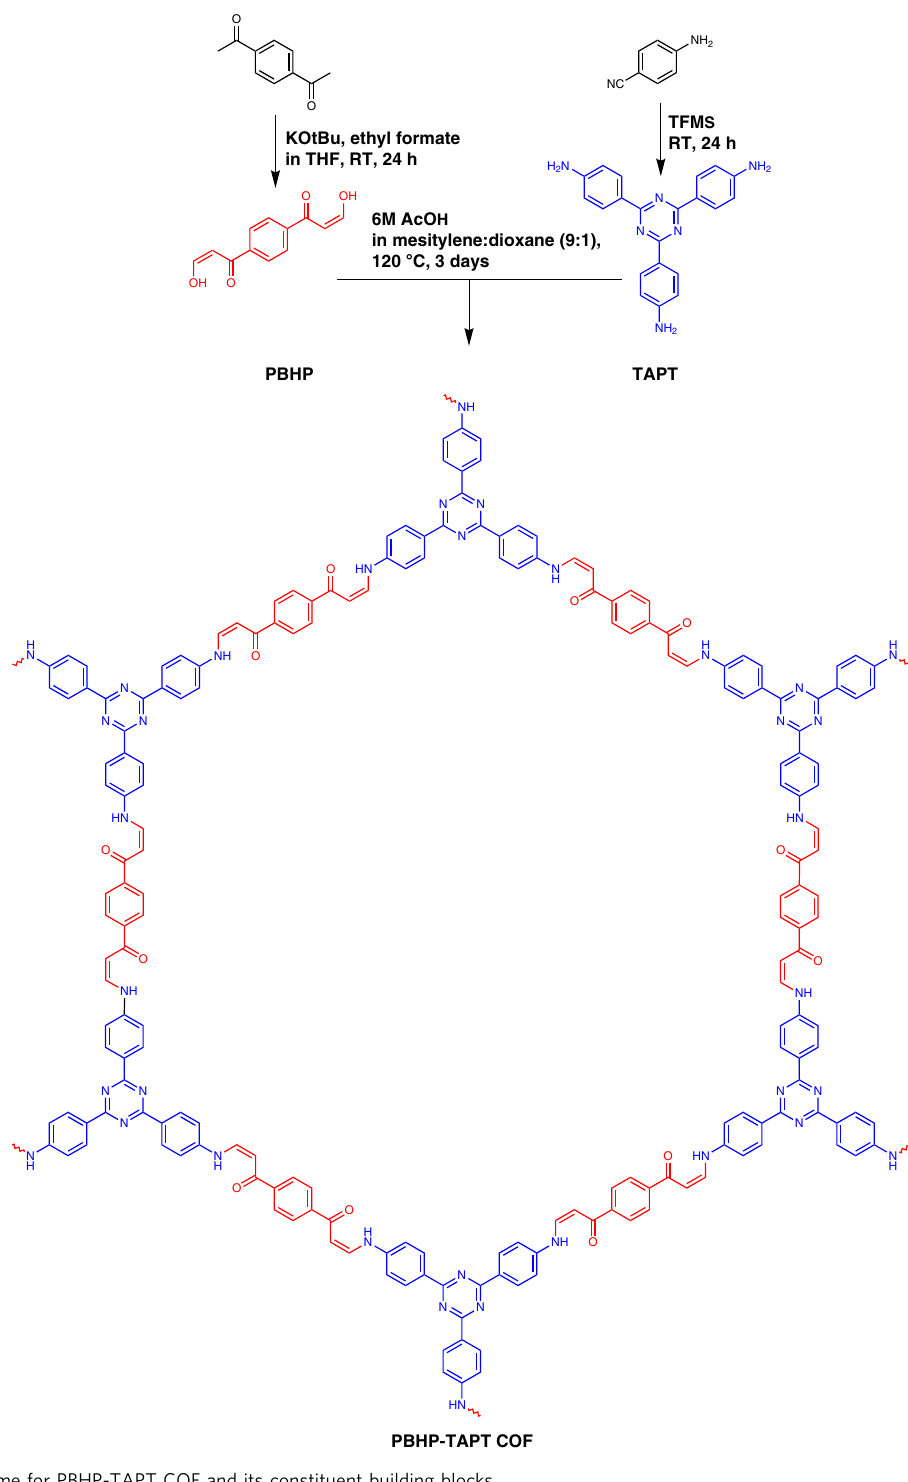
(Supplementary Fig. 11d). Pore size distribution was calculated using quenched solid-state functional theory (QSDFT) (Supple- mentary Fig. 11e), and the largest contribution to pore volume stems from pores of diameter 3.9 nm, which is close to the pore channel diameter of the re fi ned structure of 3.6 nm (Supplemen- tary Fig. 11a). Note, that the observed surface area is far from the